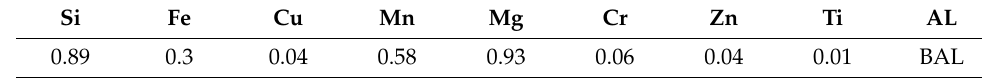
Table 1. Composition of 6082 aluminum alloy.